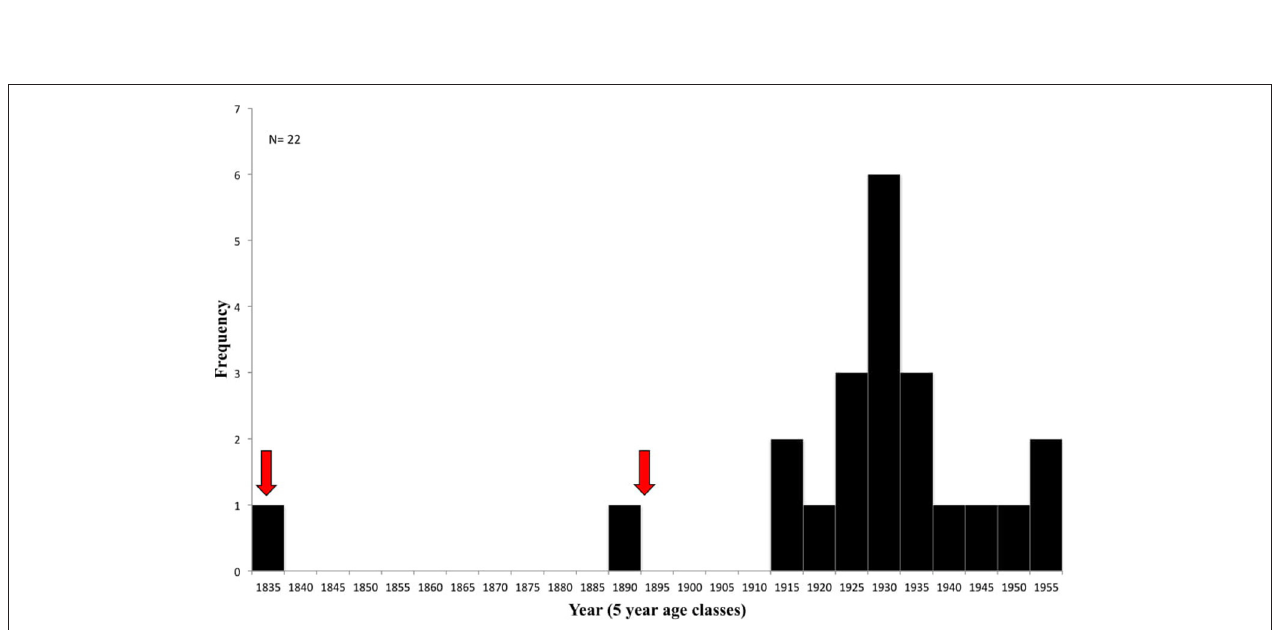
FIGURE 8 | Relative abundance pollen diagram for Spindly Pine Lake. CONISS was used to determine significant changes in vegetation, identifying 4 main pollen zones. Stomata are shown as presence or absence. A total of 300 pollen grains were counted for all depths.